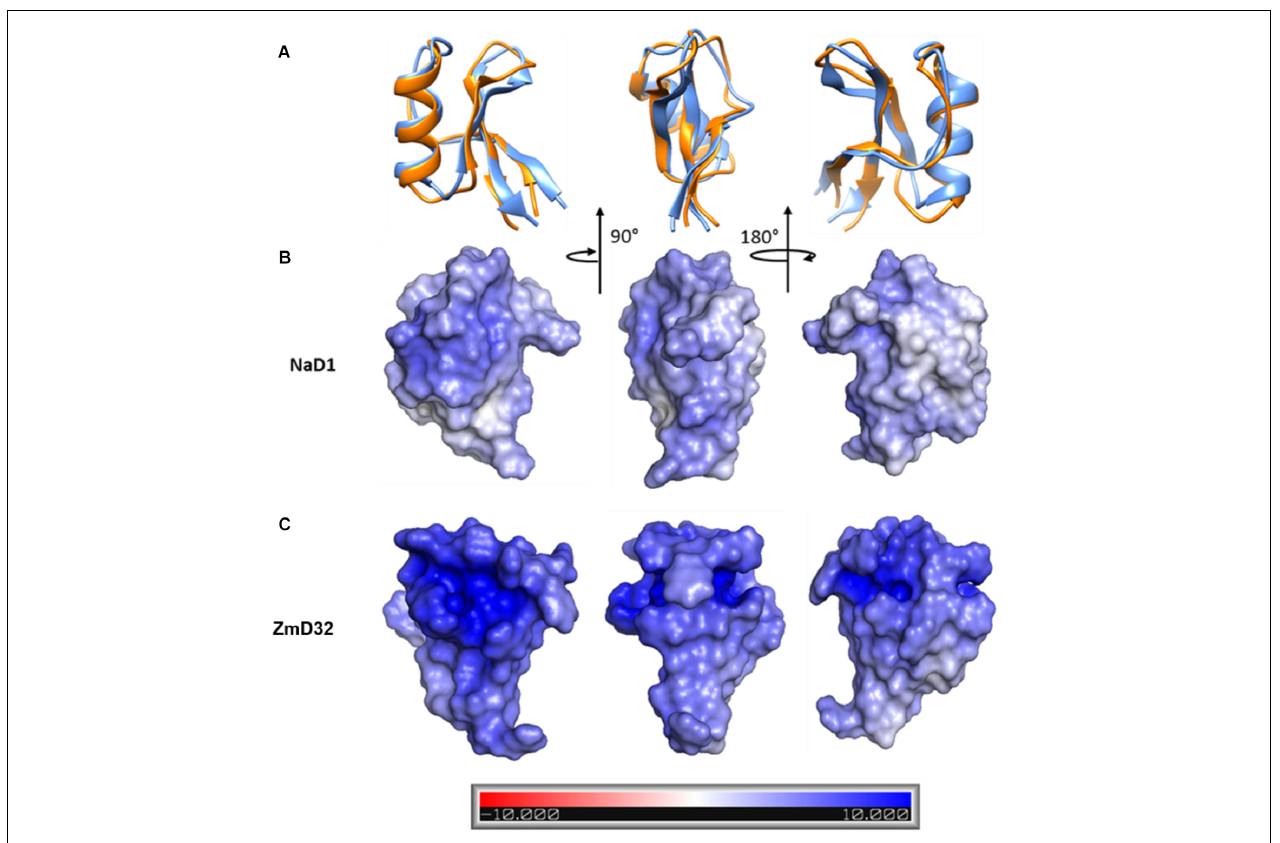
FIGURE 6 | Solvent accessible surface potential charge of ZmD32 and NaD1 generated by Pymol. (A) Superimposed model of ZmD32 and NaD1 showing different faces by 90 and 180 degree turns. Solvent accessible surface potential charges for (B) NaD1 and (C) ZmD32 generated by Adoptive Poisson-Boltzmann Solver (APBS) using Pymol from its Plugin menu. The surface charges are analyzed based on the dielectric constant at ± 10 (bar). The white surface regions have zero net charge whereas the blue surface represents the cationic regions. The intensities of the cationic regions vary with the weak cationic regions in light blue and the most highly cationic regions shown in a more intense blue. The cartoon diagram and the solvent accessible surface potential were generated using the visualization programs Chimera (UCSF) and Pymol,